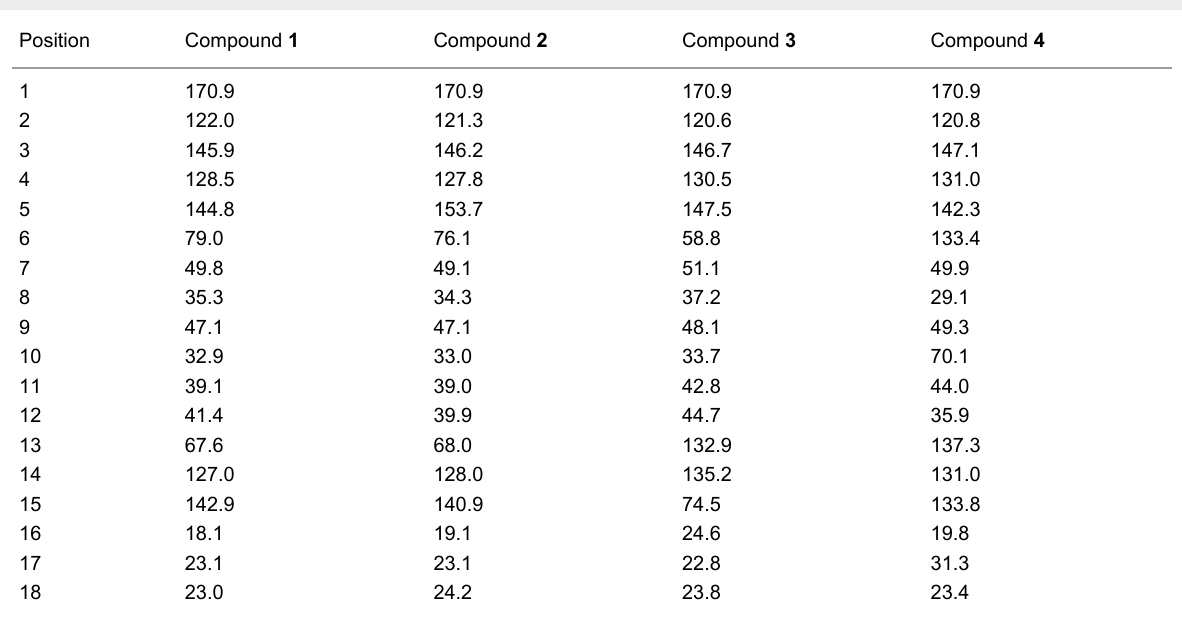
Table 2: 13 C NMR data of compounds 1 – 4 (CD 3 OD, 150